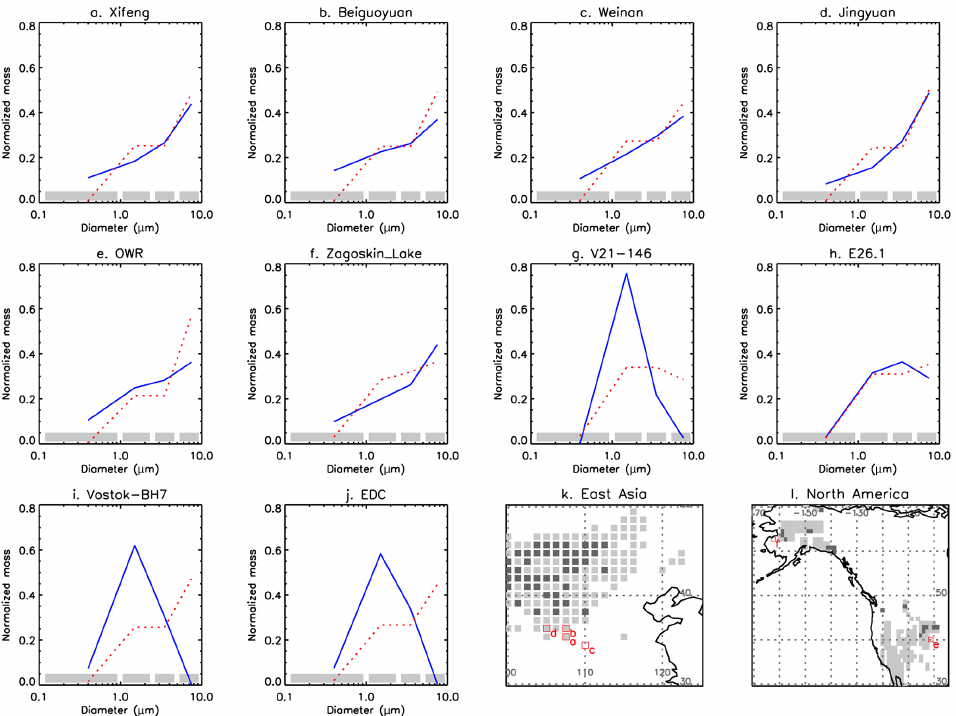
Figure 18. Comparison of modeled and observed particle size distributions for the 6kaBP time slice. Panels (a) – (j) show the modeled size distribution (red dashed line) and the observed particle size distribution (blue solid line). The normalized observational size data from the re-binned distributions were first averaged over the 5–7kaBP interval; then the size distribution data were aggregated in order to match the model dimensional bins (highlighted by the horizontal grey bars). Both the modeled and observed size distributions are normalized over the model size range, i.e., over the four size bins. Panels (k) and (l) show the relative geographical position of terrestrial records (red empty squares) and the model dust sources (filled grey squares) for eastern Asia and North America, respectively. Light grey squares indicate modeled dust mobilization flux >0, and dark grey squares denote the major dust sources, i.e., mobilization flux >200gm − 2 a − 1